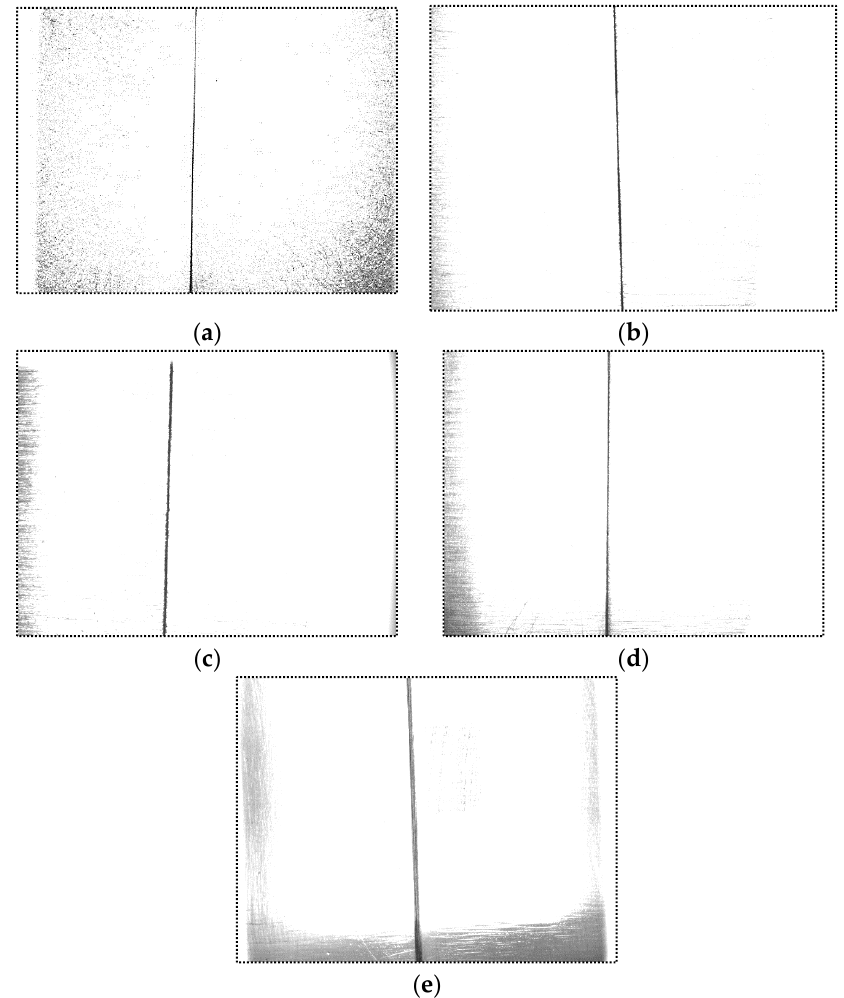
Figure 9. The original captured images of aluminum alloy with different surface roughness. ( a ) The surface roughness is about 12.5 μ m; ( b ) The surface roughness is about 6.3 μ m; ( c ) The surface roughness is about 3.2 μ m; ( d ) The surface roughness is about 1.6 μ m; ( e ) The surface roughness is about 0.8 μ m.